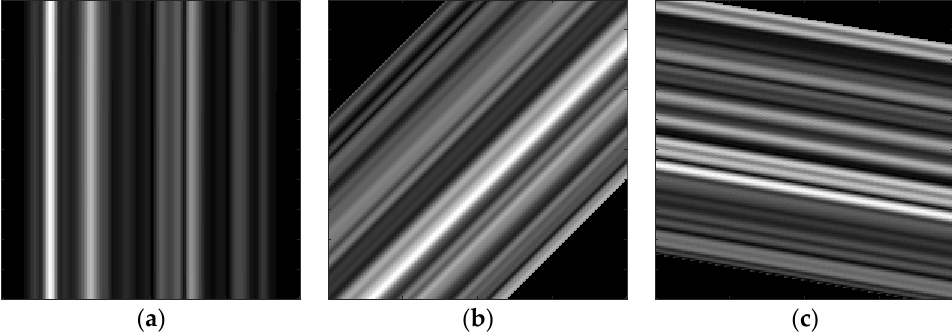
Figure 1. Single azimuth stripe image: ( a ) azimuth = 0°; ( b ) azimuth = 45°; ( c ) azimuth = 100°.